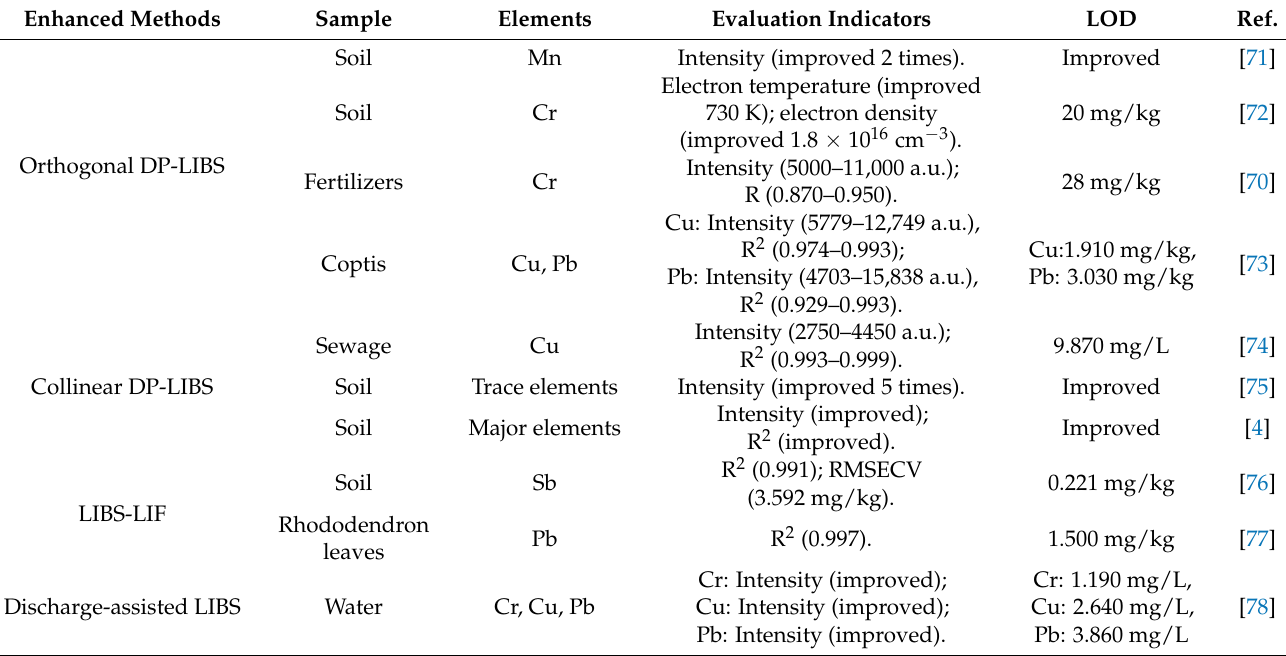
Table 2. Adding laser pulses enhanced LIBS for heavy metal